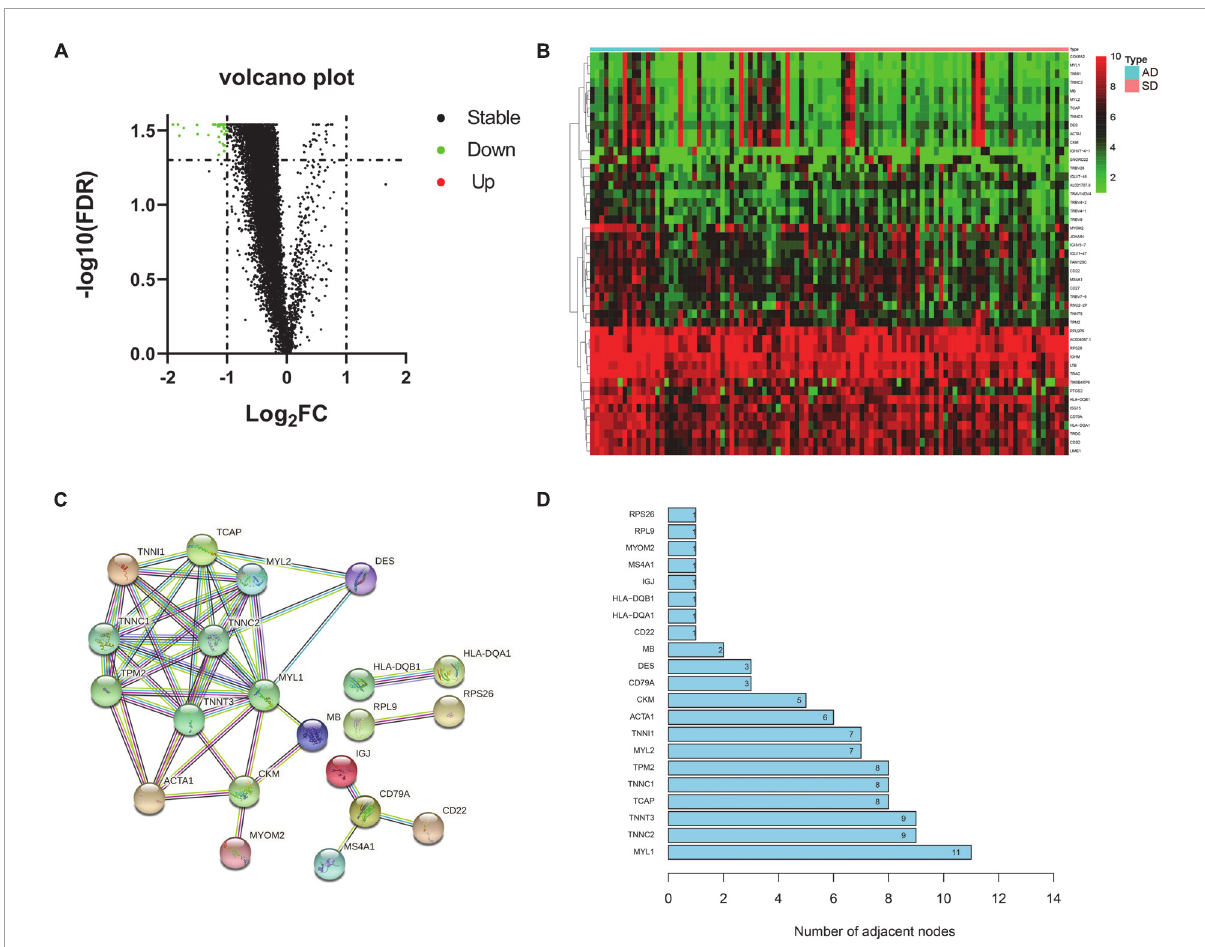
FIGURE1 Differential expression and core gene screening. (A) Volcano plot of all genes. (Red dots represent up-regulated genes and green dots represent down-regulated genes). (B) Heatmap of differential genes in AD and SD groups. (Rows represent 47 differential genes and columns represent samples). (C) PPI network of differential genes. (Nodes represent hub genes. Lines represent interactions between hub genes). (D) Bar graph of all hub genes in the PPI network. (The x-axis represents channel counts. The y-axis represents hub genes). AD, Accidental death; SD, Sudden